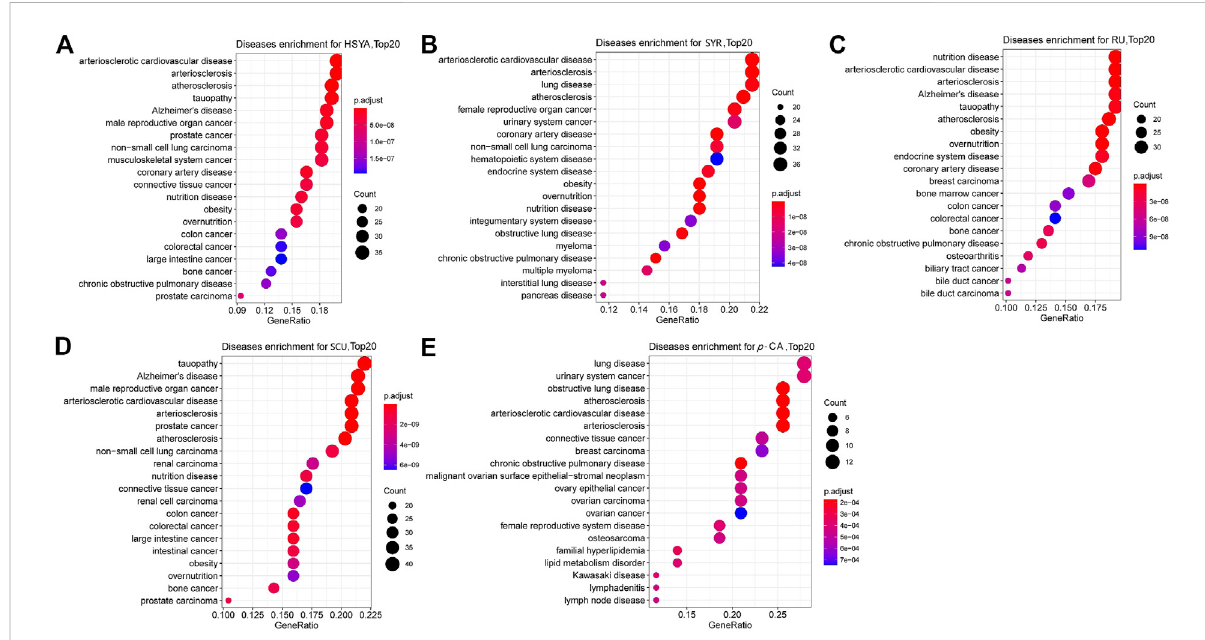
FIGURE 3 DOSE analysis plots for the fi ve ingredients, (A) HSYA, (B) SYR, (C) RU, (D) SCU and (E) p -CA with favorable PK properties. The top 20 diseases relative to the corresponding ingredient and potential targets are shown in the